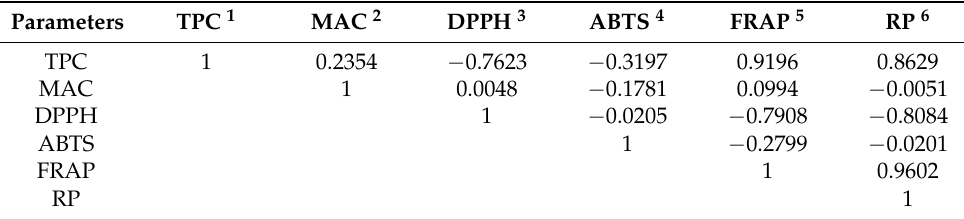
Table 2. Correlation coefficients between values of analyzed parameters.